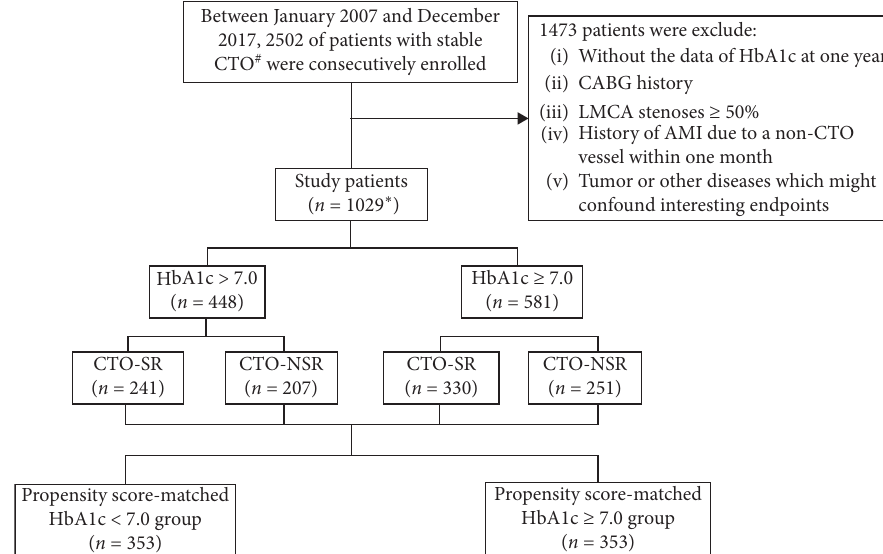
Figure 1: Study scheme. AMI: acute myocardial infarction; CABG: coronary artery bypass grafting; CTO: chronic total occlusion; LMCA: left main coronary artery; CTO-SR: successful CTO revascularization, a successful revascularization for the CTO vessel by percutaneous coronary intervention (PCI) or coronary artery bypass grafting (CABG); CTO-NSR: nonsuccessful CTO revascularization, patients failed CTO revascularization procedures or failed to try CTO revascularization (only took medicine). #Patients with manifestations of symp- tomatic stable angina or silent ischemia. ∗ A total of 989 (96.11%) patients completed the follow-up